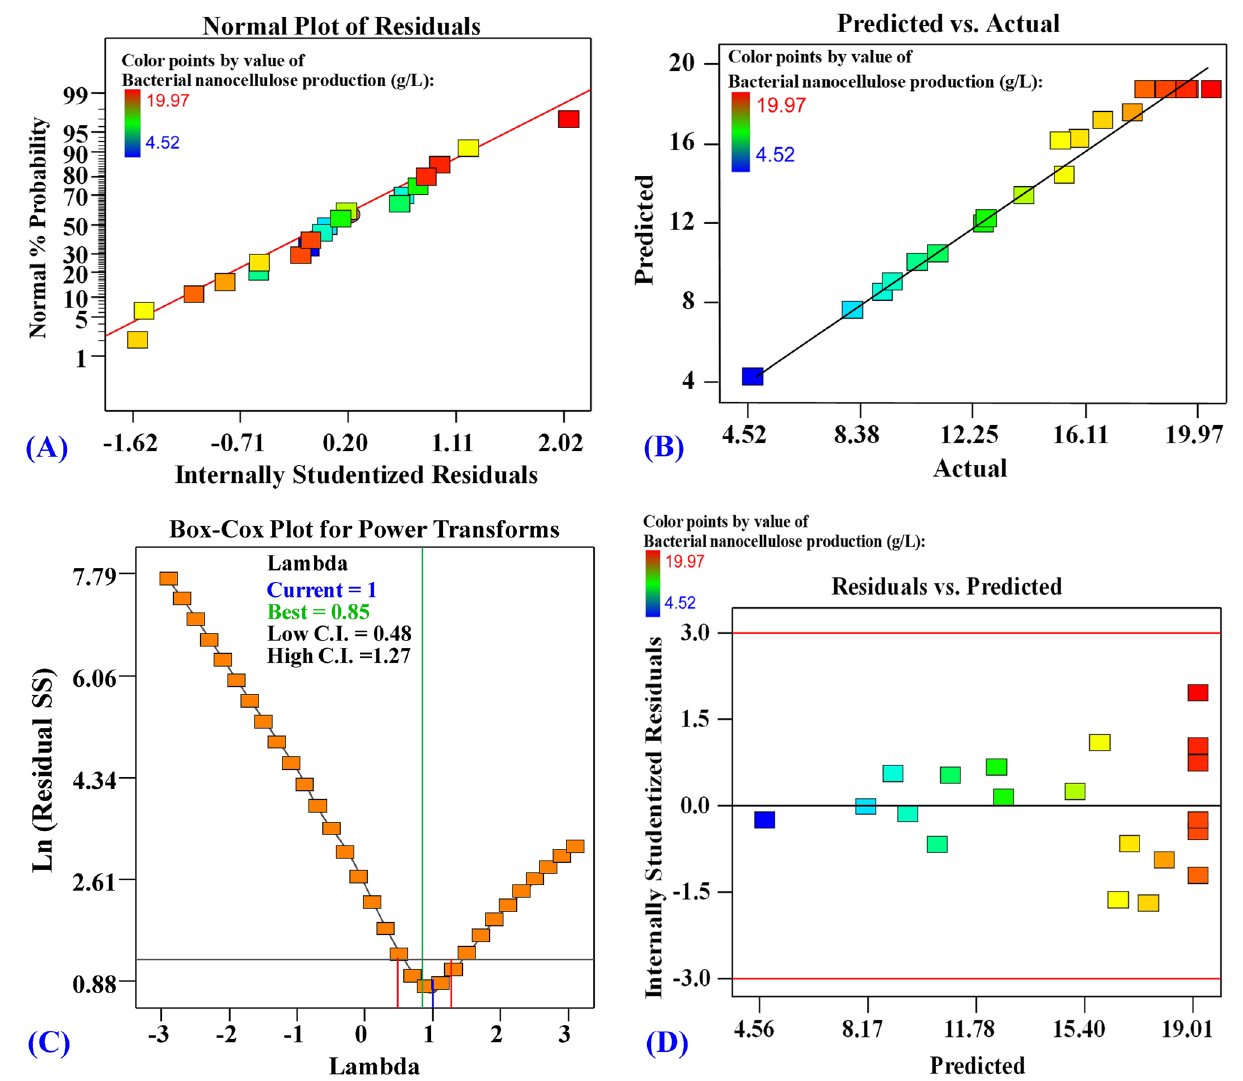
Figure 9. ( A ) Normal probability plot of internally studentized residuals, ( B ) plot of predicted versus actual, ( C ) Box–Cox plot of model transformation and ( D ) plot of internally studentized residuals versus